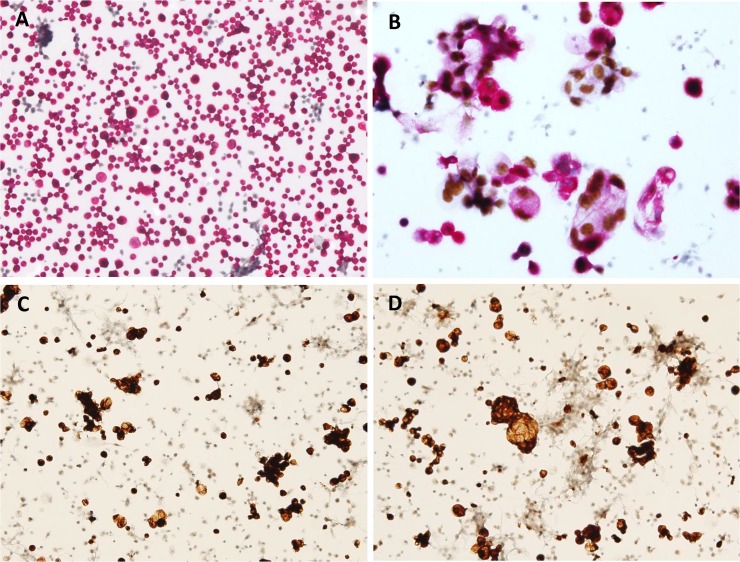
Optimizing the order of dual immunocytochemistry for CK7 and PAX8.When the antibody that is used first affects the overall manifestation because the first applied color becomes weak or even completely lost following staining with the second color. (A and B) Nuclear staining, using PAX8-specific antibody with DAB, was performed first followed by cytoplasmic or membranous staining using CK7-specific antibody with Fast Red. (C and D) CK7 staining was performed first followed by PAX8 staining. The initially applied CK7 red color becomes completely lost following DAB staining in the same case as in A and B.